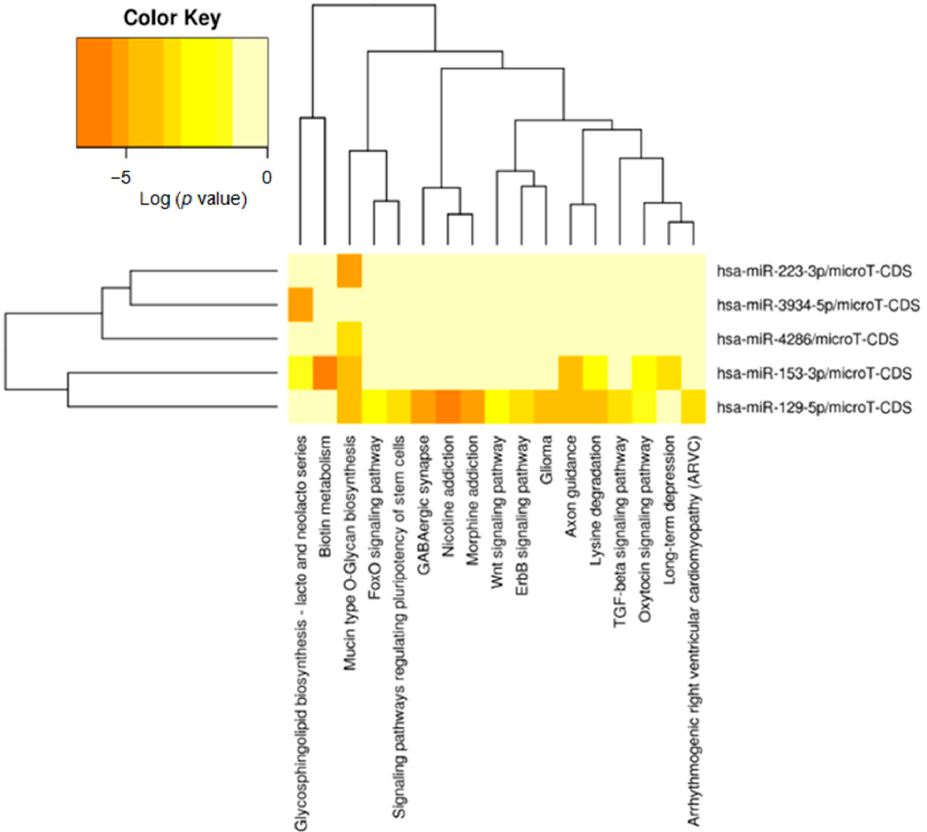
Figure 3. KEGG pathway heatmaps of differentially expressed miRNAs with significantly different expression in mitotic counts ( p < 0.01).